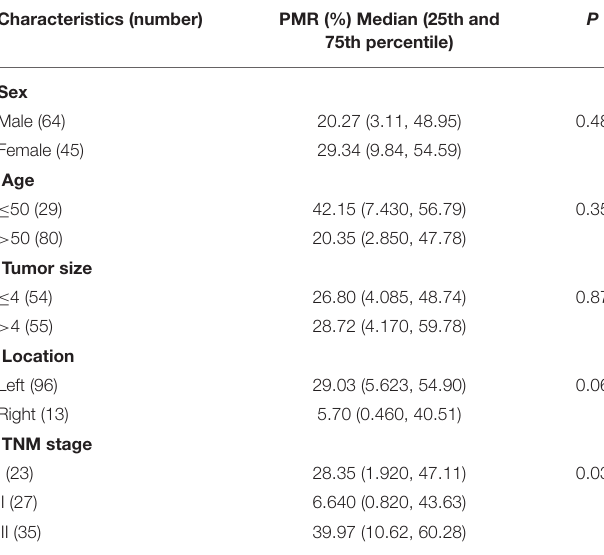
TABLE 1 | PMR results according to the clinical characteristics of colorectal cancer patients in this study. Characteristics